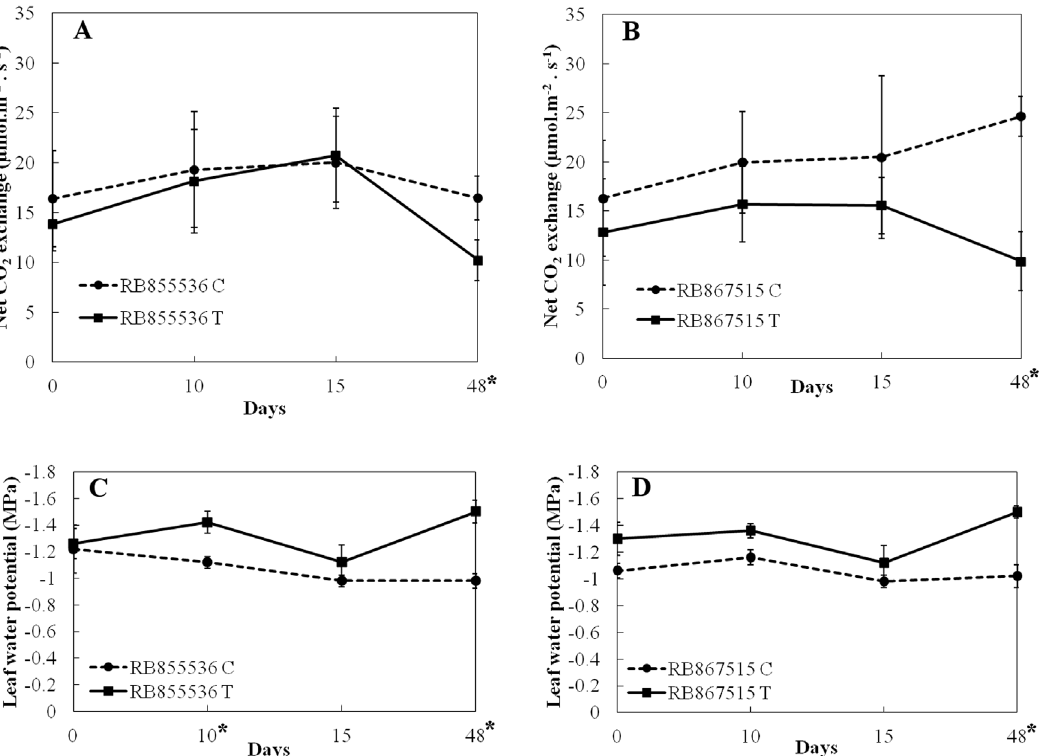
Figure 1. Net CO 2 -exchange ( m mol.m 2 2 s 2 1 ) for (A) cultivar RB855536 and (B) cultivar RB867515 over time. Leaf water potential (MPa) in N sugarcane leaves during 48 days of salt treatment for (C) cultivar RB855536; and (D) cultivar RB867515. Values are presented as mean 6 SD (n=6). " are control plants and " & " are salt-treated plants. *Significant at p # 0.05. "